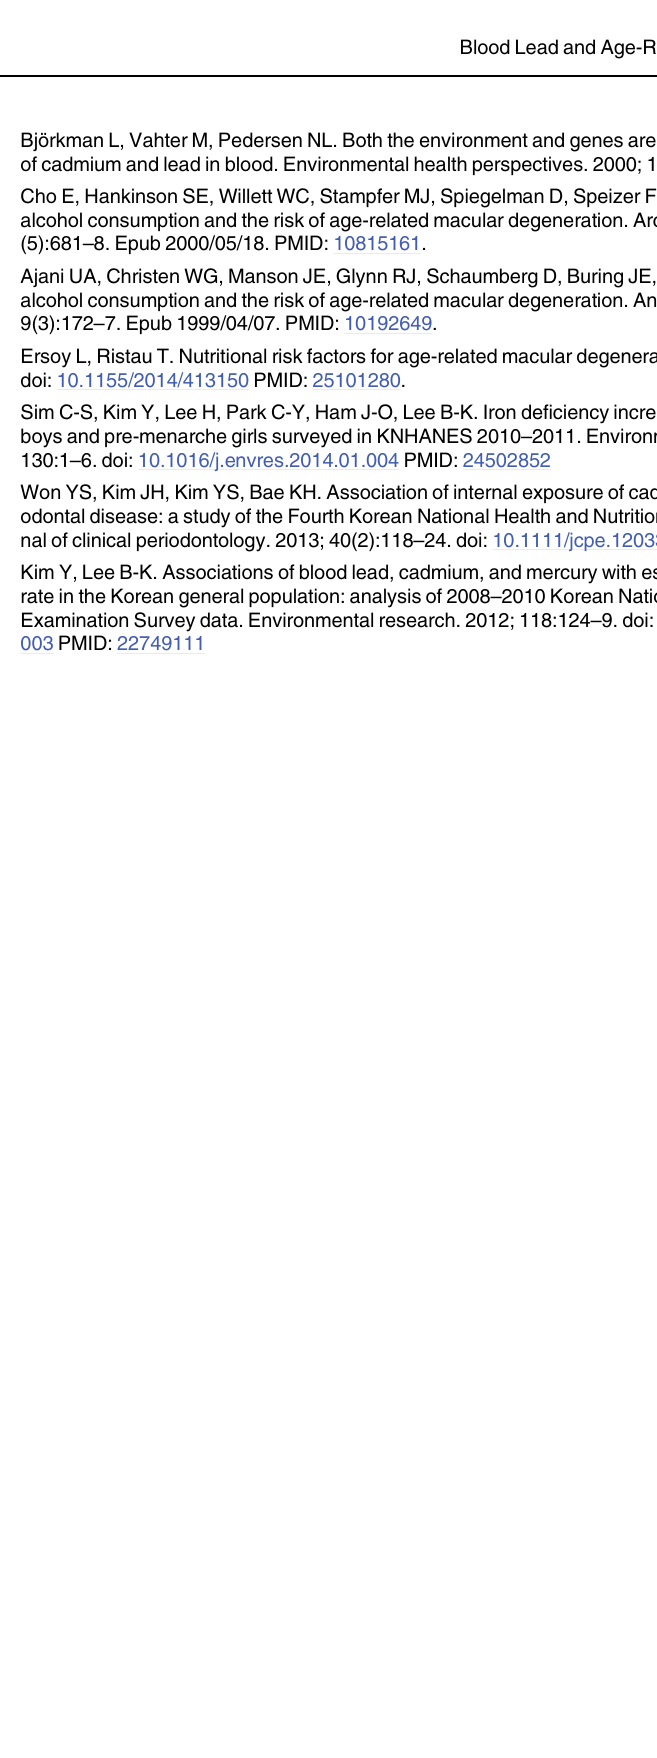
PLOS ONE | DOI:10.1371/journal.pone.0134338 August 7,